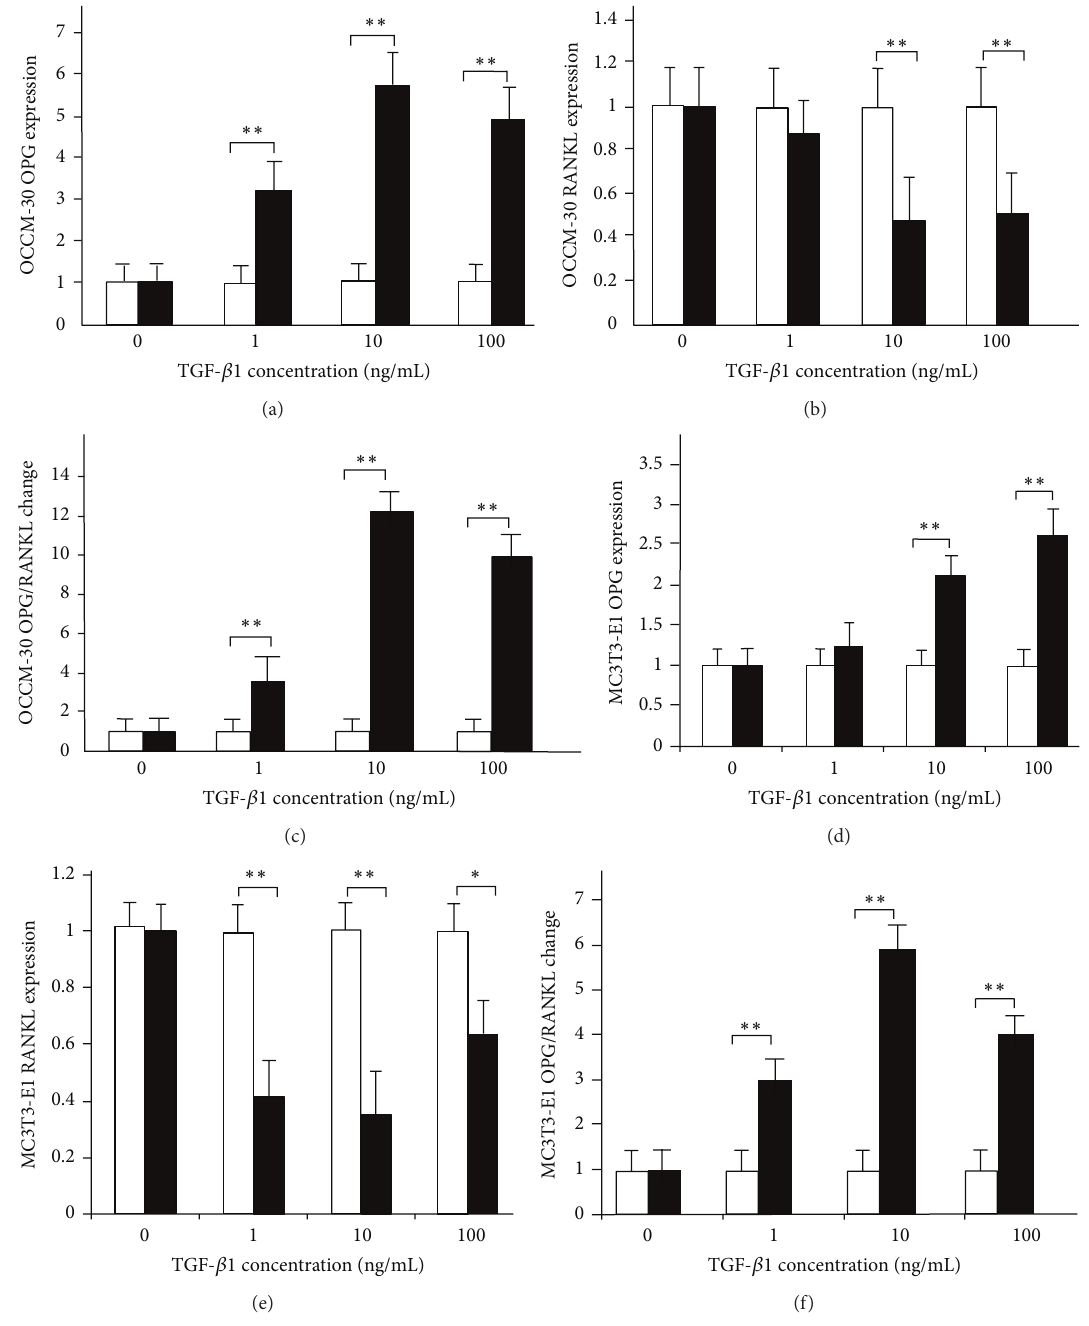
Figure 6: Effects of TGF- 𝛽 1 on cementoblasts and osteoblasts under 3 h mechanical compressive stress.